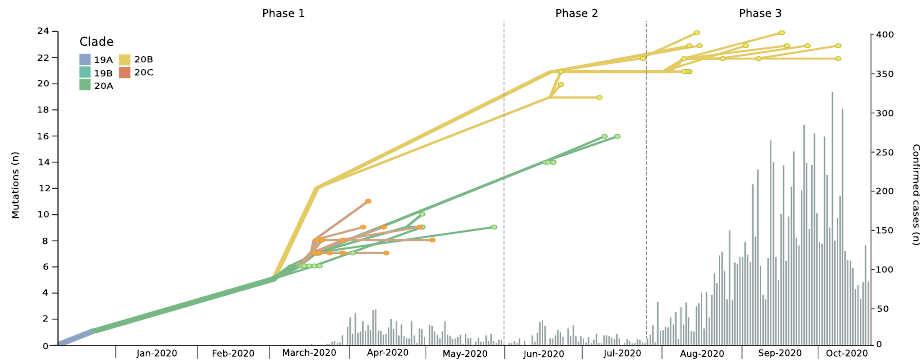
Figure 1. Phylodynamic evolution and new daily cases incidence in the Magallanes Region. The phylodynamic tree depicts the number of mutations of isolated genomes during the study period in the Magellanes Region; colors refer to Nextstrain clade classification (upper left corner) of analyzed strains. Clade defining mutations: 19A Wuhan Strain; 19B: ORF8 251S; 20A: Spike 614G; 20B: derived from 20A bearing Nuclocapsid 203K, N204R and ORF14 50N; 20C: derived from 20A bearing ORF3a 57H and ORF1a 265I. Histogram chart showing daily incidence rates of confirmed COVID-19 cases in the Magallanes